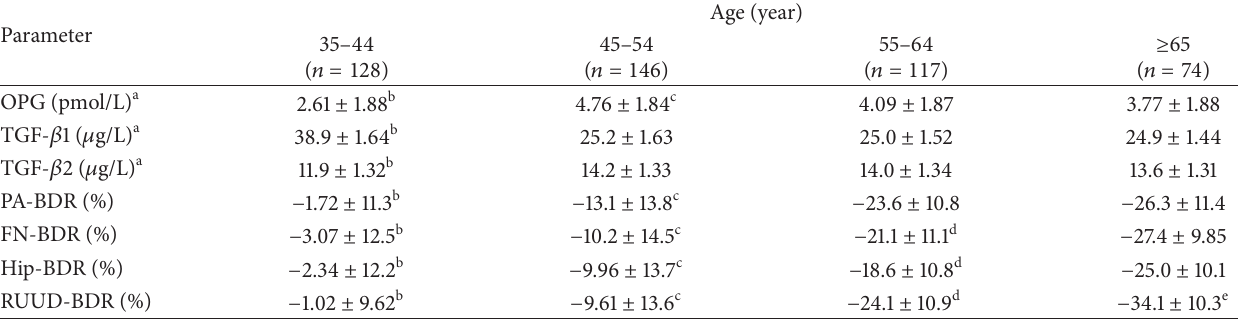
Table 2: Age-related serums OPG, TGF- 𝛽 1, and TGF- 𝛽 2 and BDR at different skeletal sites in native Chinese